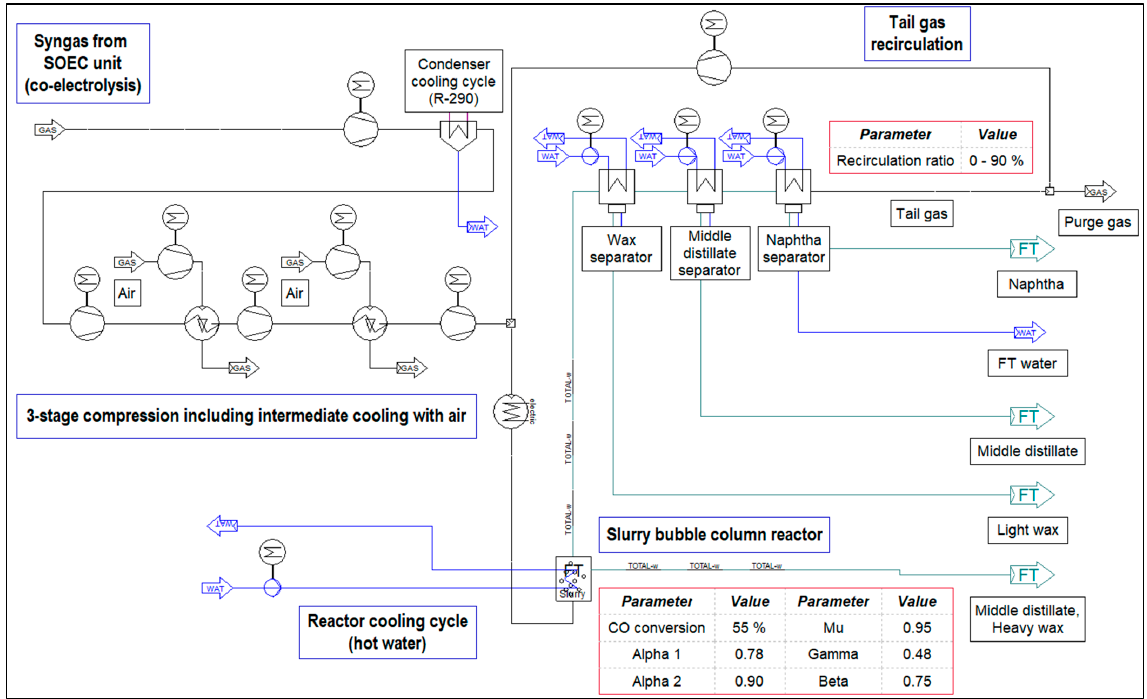
Figure 3. Implementation in IPSEpro—process configuration without tail gas reforming.